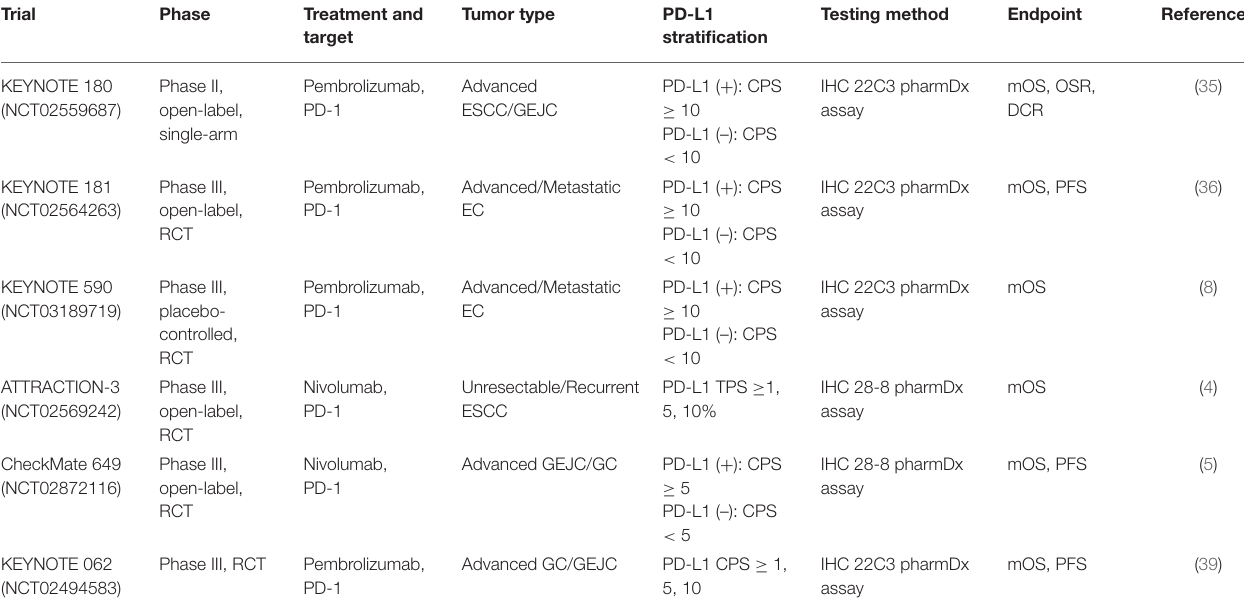
TABLE 1 | The clinical trials when PD-L1 expression as a biomarker.